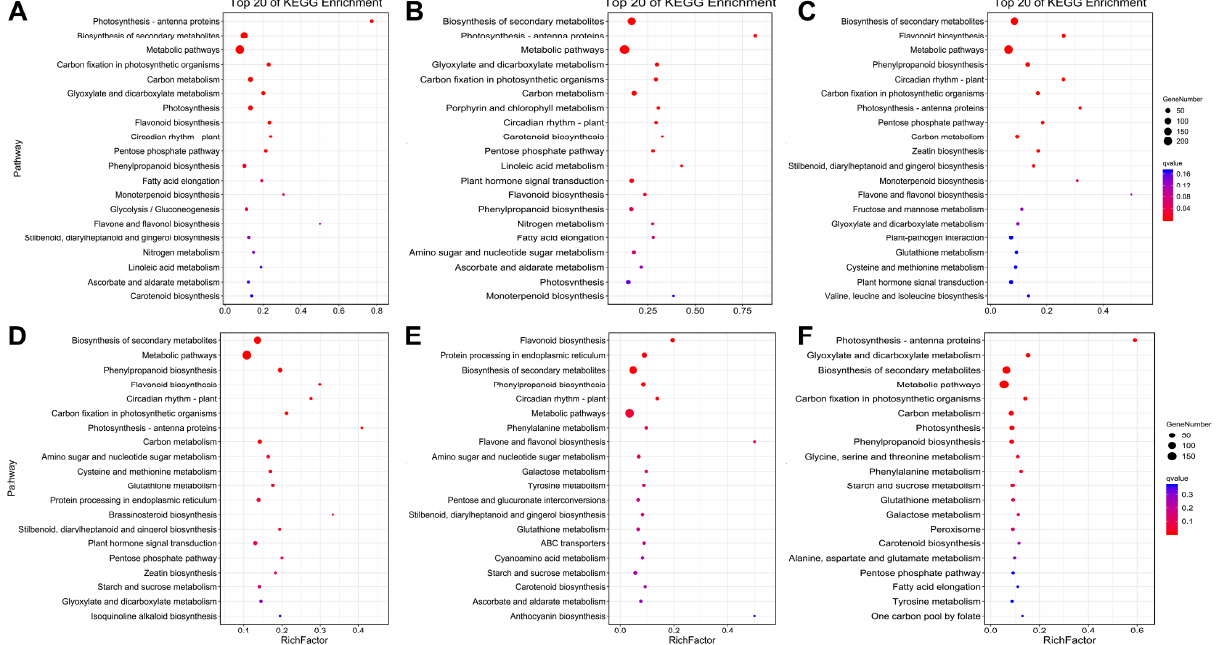
Figure 3. KEGG enrichment bubble plot. The first 20 pathways with the smallest Q values were used for the plot, with pathway as the ordinate and enrichment factor as the abscissa (the differentially expressed genes in this pathway are divided into groups based on the numbers shown). The size indicates the number, and the redder the color is, the smaller the Q value (( A ) comparison group CK1-P vs. T1-P; ( B ) comparison group T1-P vs. T2-P; ( C ) comparison group CK1-NP vs. T1-NP; ( D ) comparison group T1-NP vs. T2-NP; ( E ) comparison group T1-P vs. T1-NP; and ( F ) comparison group T2-P vs.